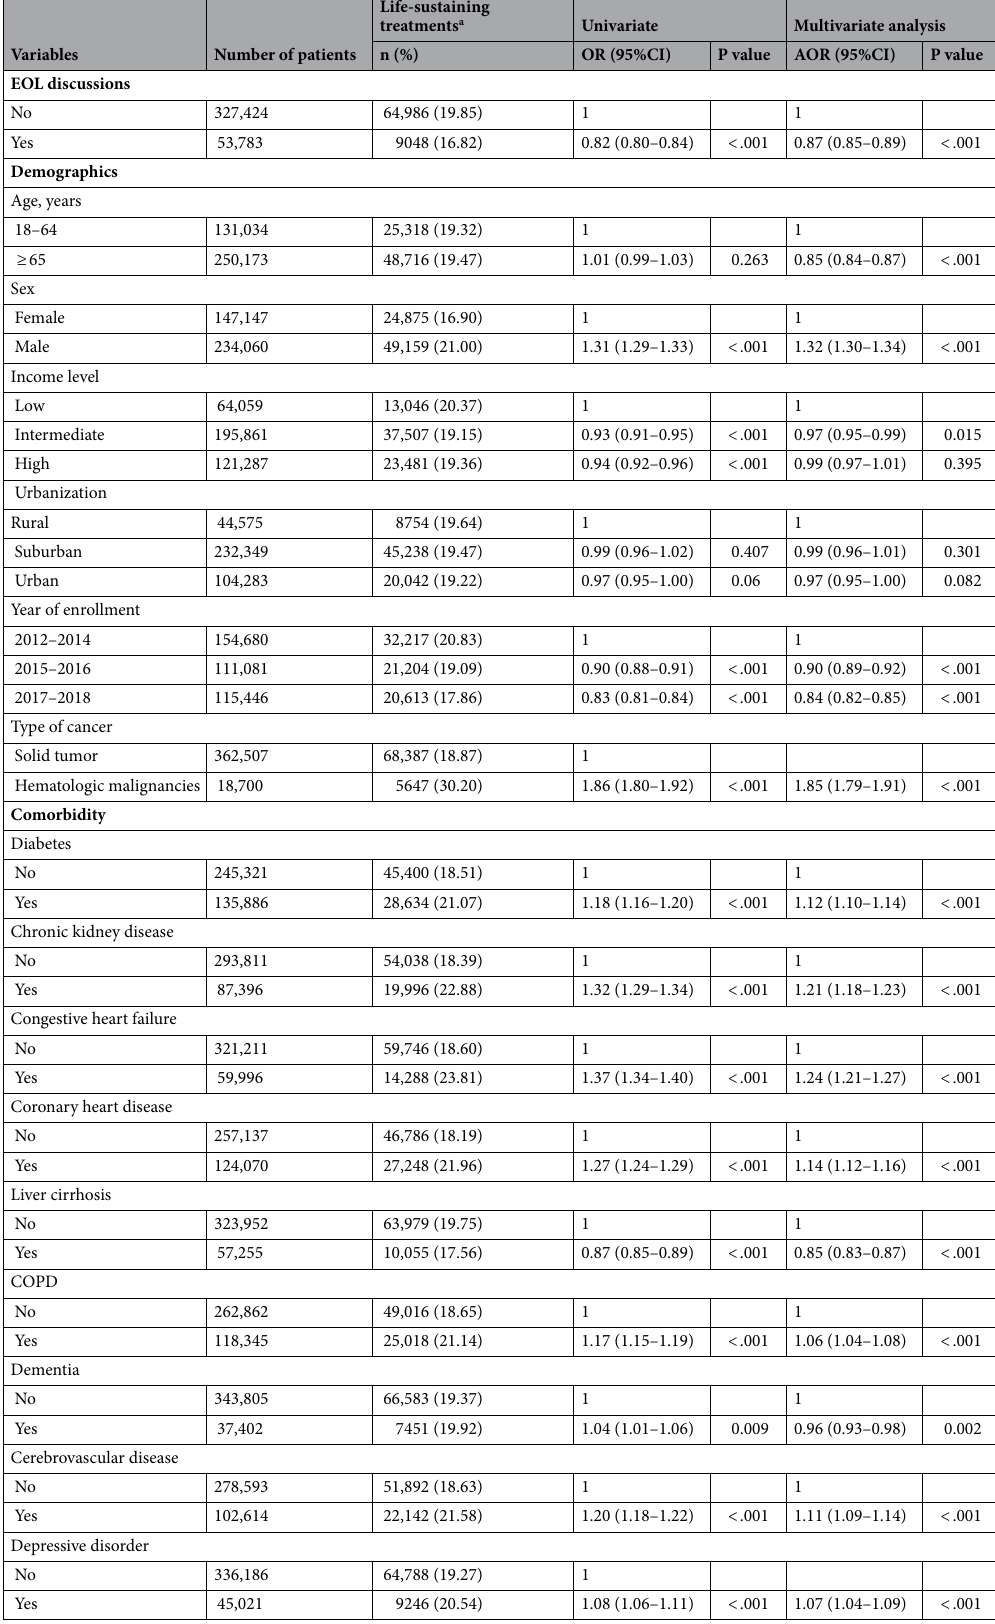
Table 2. Univariate and multivariate analysis of factors associated with utilization of life-sustaining treatments during the last 3 months of life among deceased cancer patients. AOR, adjusted odds ratio; CI, confident interval; EOL, end-of-life; COPD, chronic obstructive pulmonary disease. a During the last 3 months of